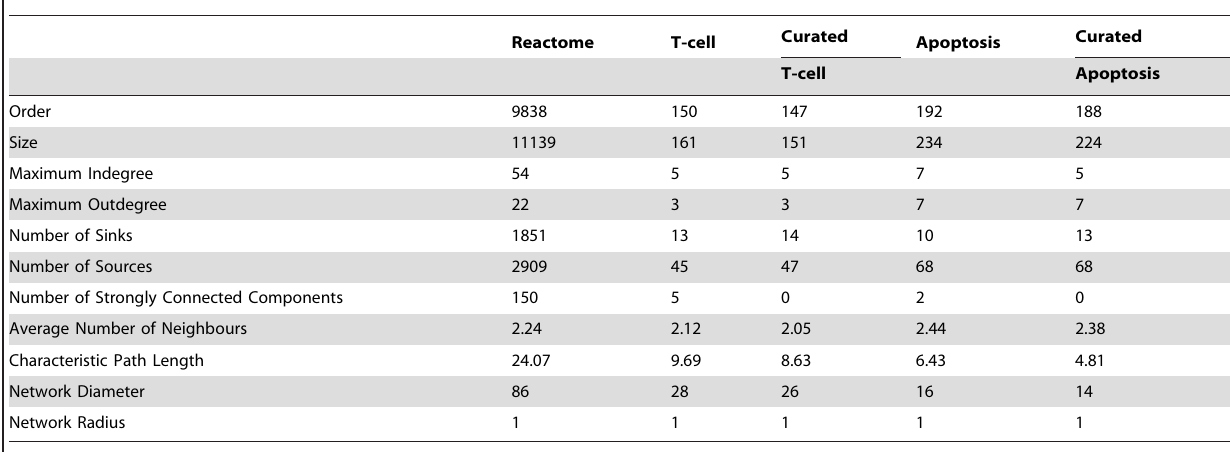
Table 2. Data Properties and Statistics.